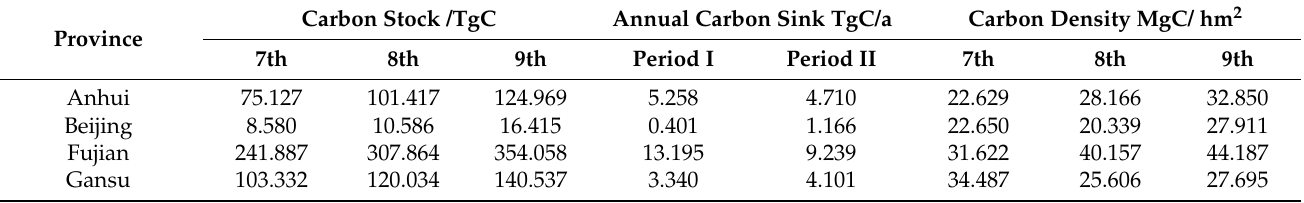
Table 5. Forest carbon storage, annual carbon sink increases, and carbon density of provinces in